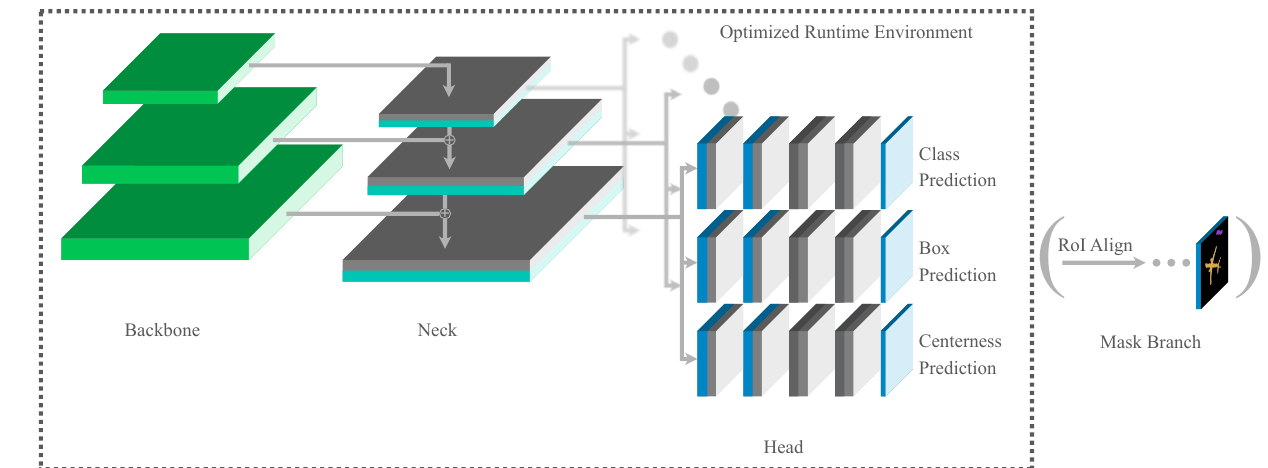
Figure 1. Overview of Our Architecture Adjustments. Grey convolutions and unsaturated channels are removed to decrease runtime while preserving a good accuracy. The mask branch is improving the detection accuracy during training and can be removed for inference. A centerness prediction branch is applied to delete inaccurate detections which are triggered from a feature map pixel that is far off the detection’s center. Depending on the targeted runtime we use a smaller